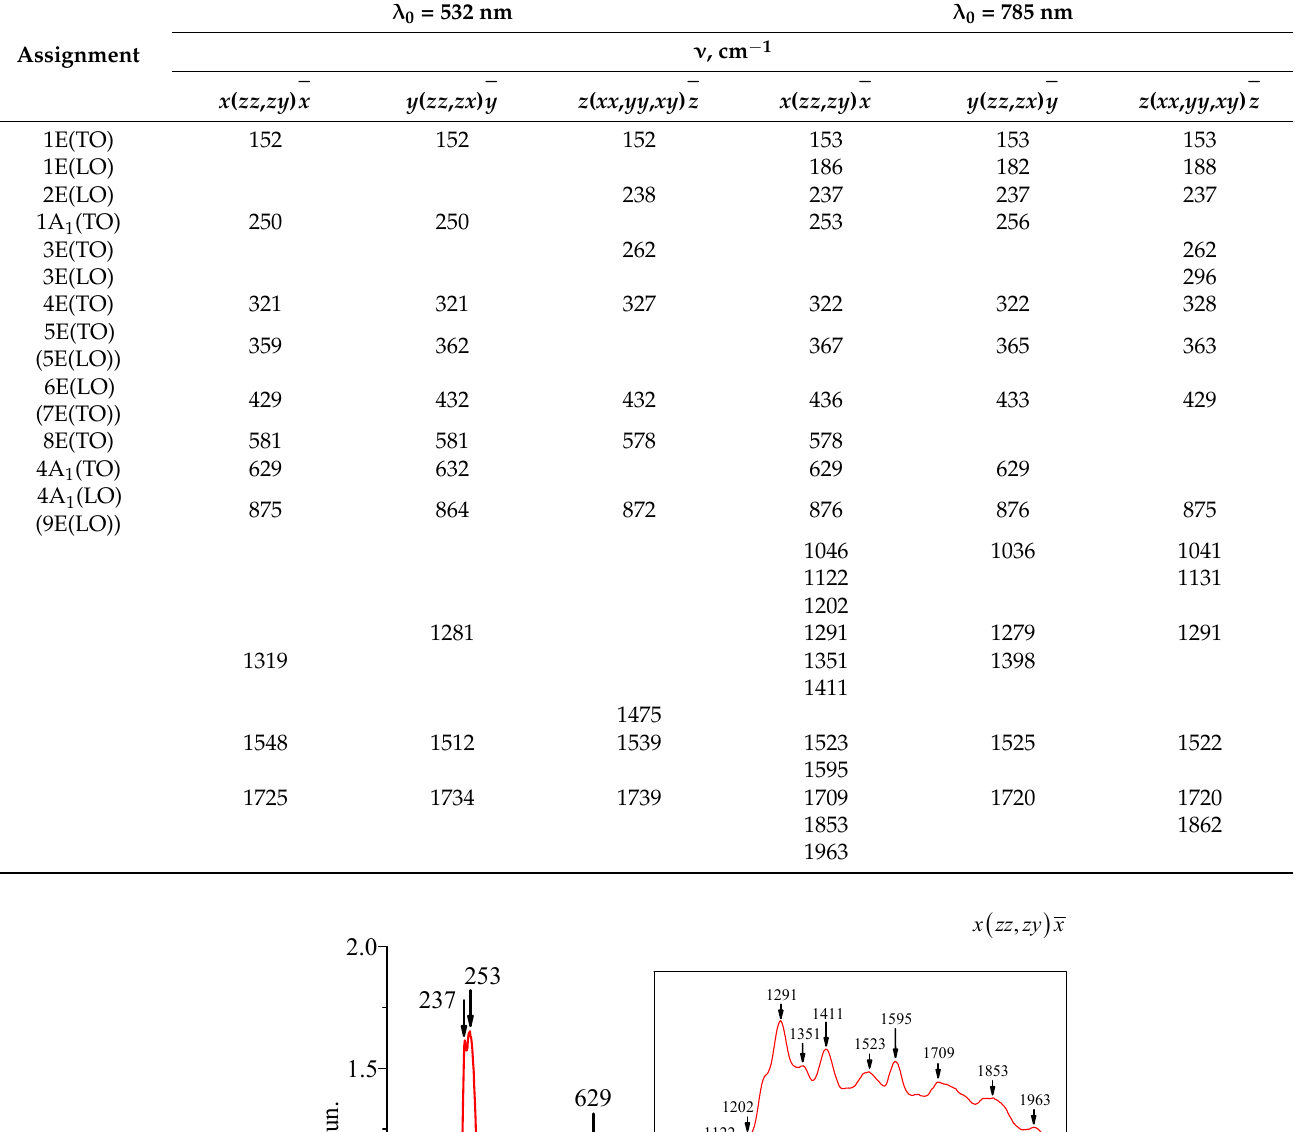
Table 2. The frequencies of transverse (TO) and longitudinal (LO) fundamental polar vibrations observed in the Raman spectrum of the LiNbO 3 :Gd 3+ (0.003):Mg 2+ (0.65 wt.%) crystal obtained in this work, as well as their assignment using [36,37]. Below are the line frequencies corresponding to the second-order spectrum.